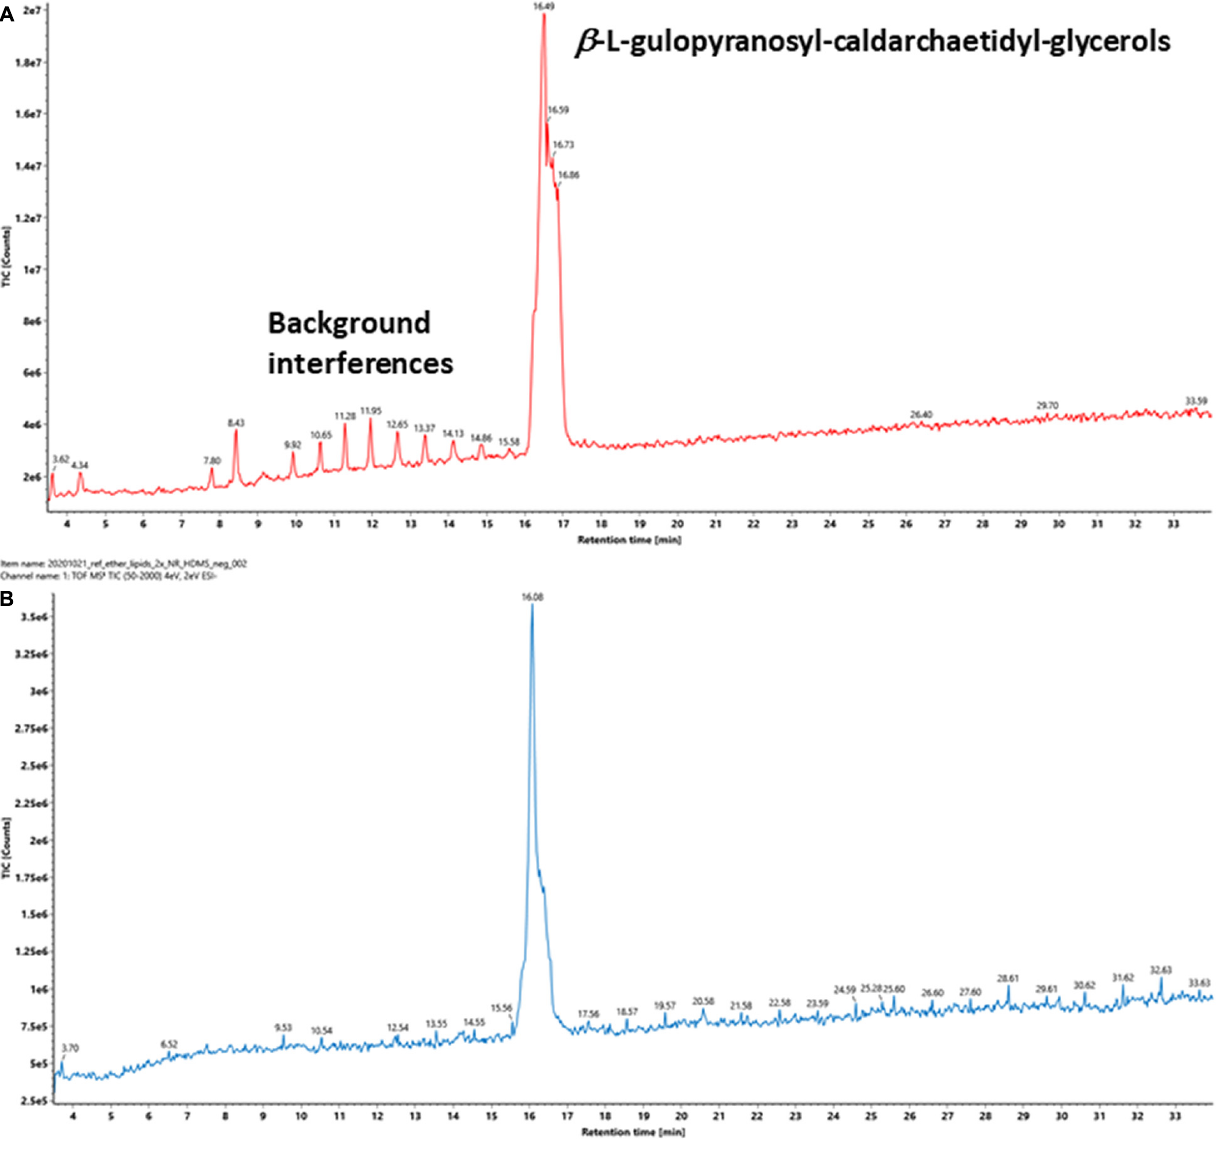
FIGURE 4 | TIC of a commercially available tetraether monosaccharide phospholipid standard acquired under (A) positive and (B) negative ion modes. The information provided by the vendor describes it contains a β -L-gulopyranosyl-caldarchaetidyl-glycerol, a glycerophosphate, and a gulosylpyranoside monosaccharide linked via a tetraether chain. The phospholipid is synthesized by Thermoplasma acidophilum, with purity >